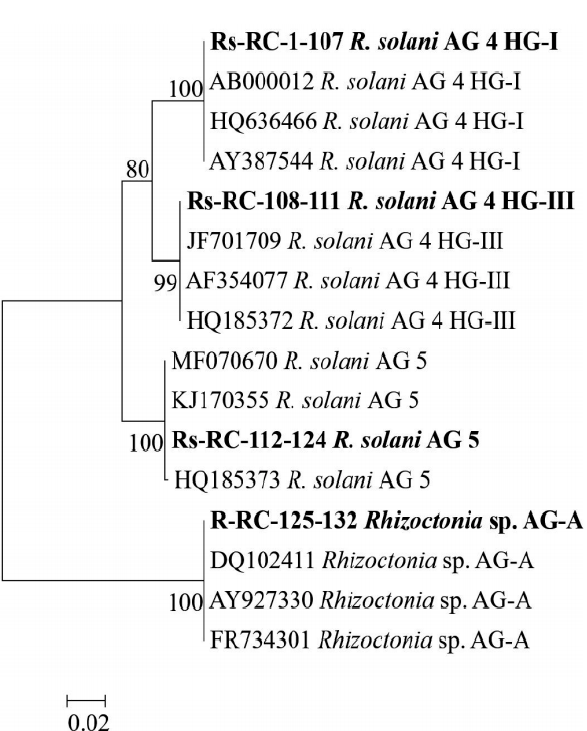
Figure 1. The Maximum Likelihood tree was generated using the ITS sequences of Rhizoctonia isolates from this study (bold) and reference isolates representing AGs from GenBank. The percentage of replicate trees in which the associated taxa clustered together in the bootstrap test (1000 replicates) is shown next to the branches.